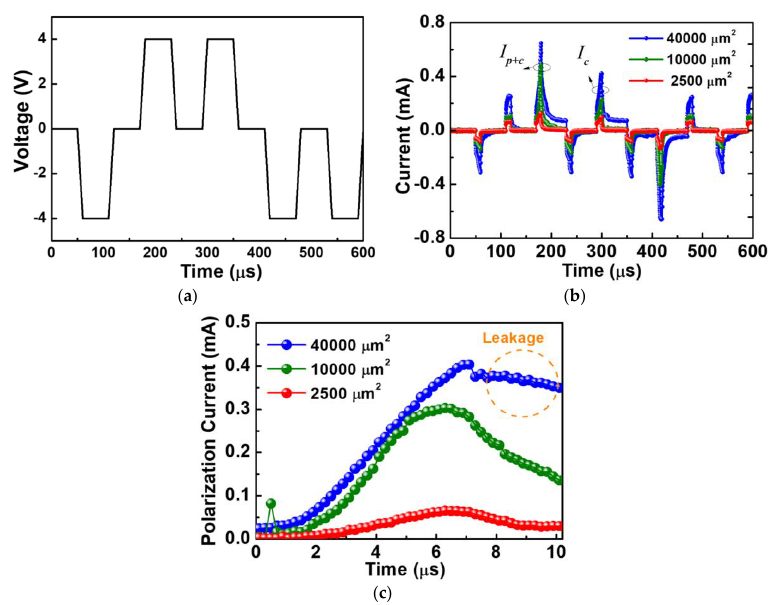
Figure 4. ( a ) Input waveform and ( b ) response currents measured by the PUND method; ( c ) Polarization current as a function of pulse time for HAO MFM capacitor with different device areas. Figure 5 shows the typical transfer drain current versus gate voltage ( I D -V G ) curves of the p -type SnO TFT in the swept mode. The I ON / I OFF ratio of the p -type SnO TFT shows 3 orders (~2 × 10 3 ) of magnitude in the I D -V G curve, and the on-state and off-state currents are 2.8 × 10 −6 A and 1.3 × 10 −9 A at V D = −1 V, respectively. It was observed that the hysteresis for the I D -V G curves under the forward